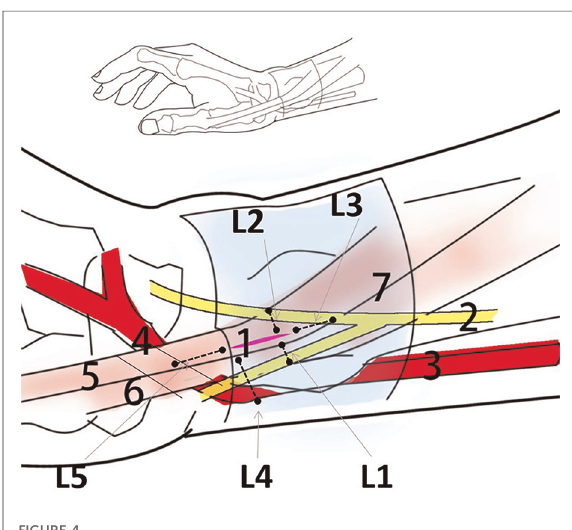
FIGURE 4 Schematic diagram of the release traces and anatomical structure of the radial styloid process with acupotomy. 1 (Purple line) needle- knife release trace; 2 super fi cial branch of the radial nerve; 3 radial artery; 4 radial artery snuff fossa; 5 extensor pollicis brevis; 6 abductor pollicis longus; 7 radial wrist